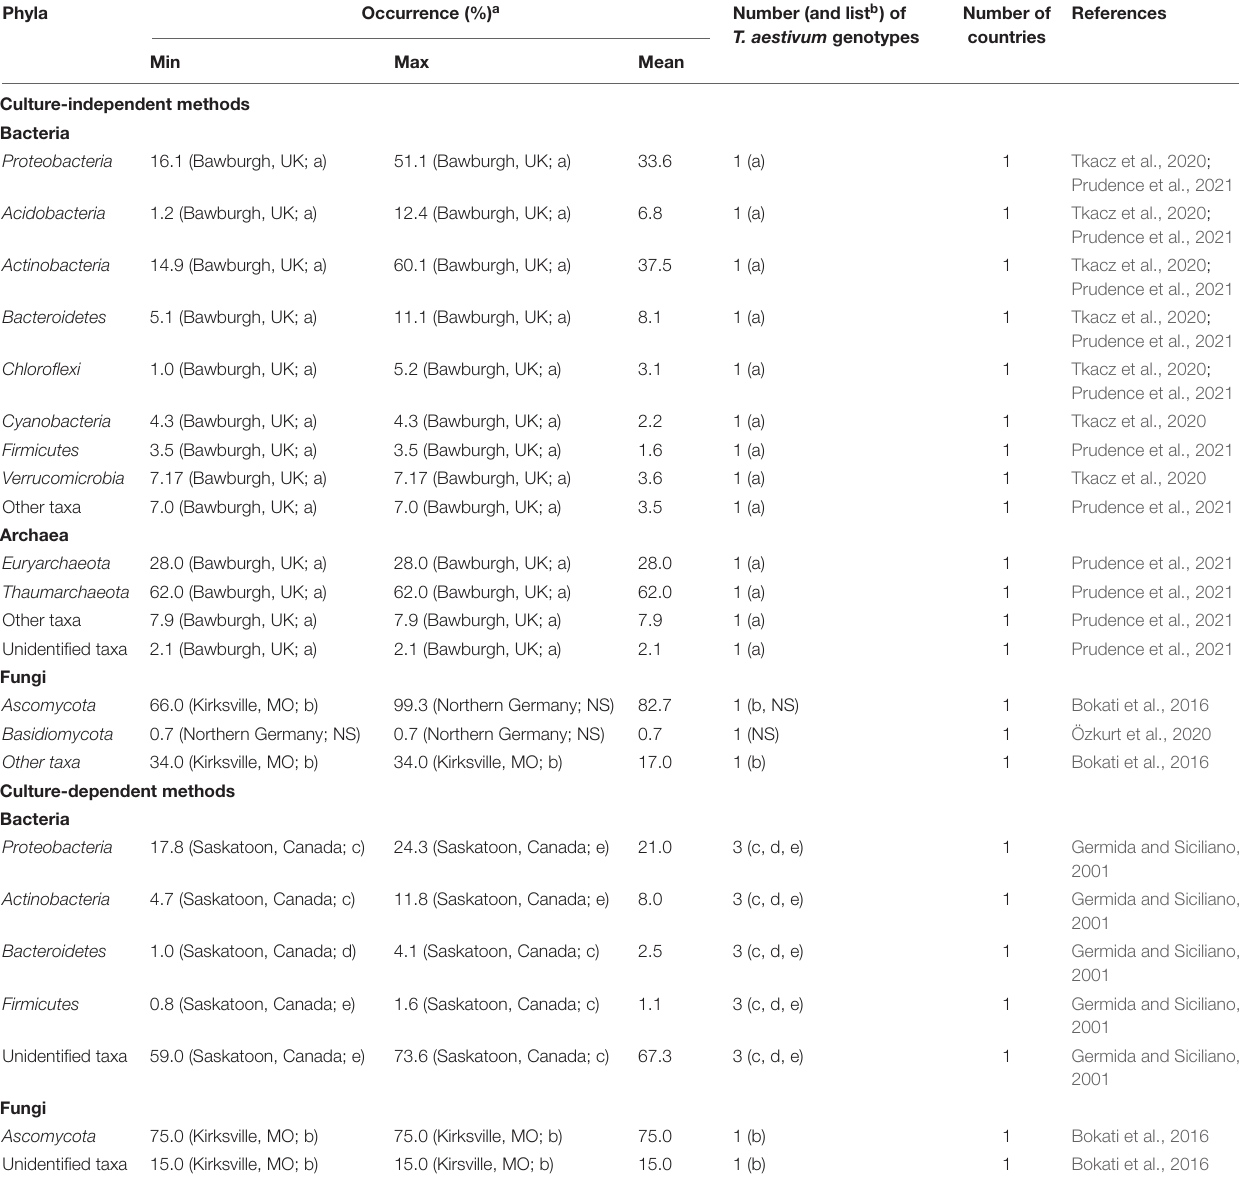
TABLE 3 | Occurrence of phyla in the root endosphere of T. aestivum , as documented by culture-independent and culture-dependent methods. Phyla Occurrence (%) a Number (and list b ) of